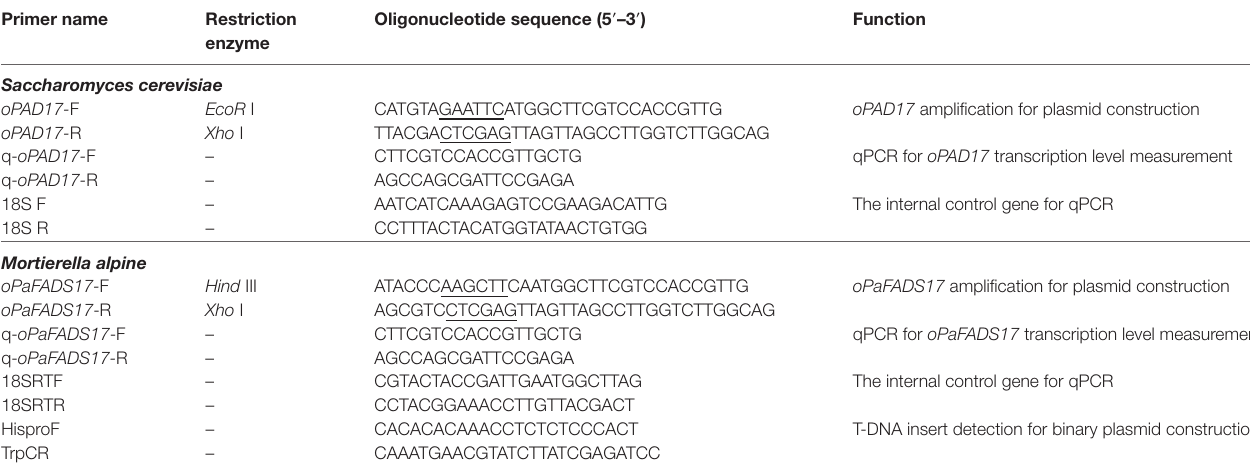
TaBle 1 | Primers used in this